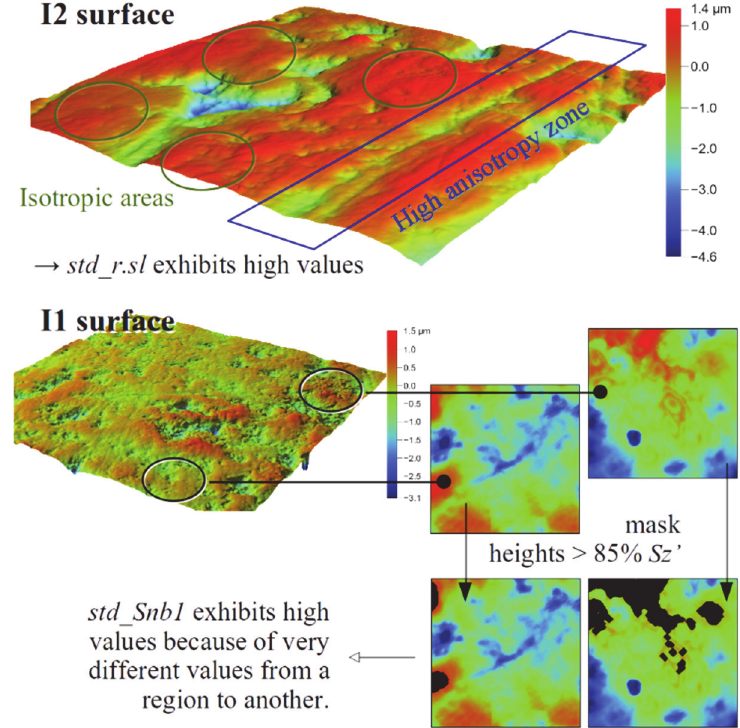
Figure 9 . I1 and I2 are separated in a biplot std_r.sl_SB / std_Snb1_SC because I2 surfaces have more areas of different anisotropy levels and I1 surfaces have more areas of different peakedness.